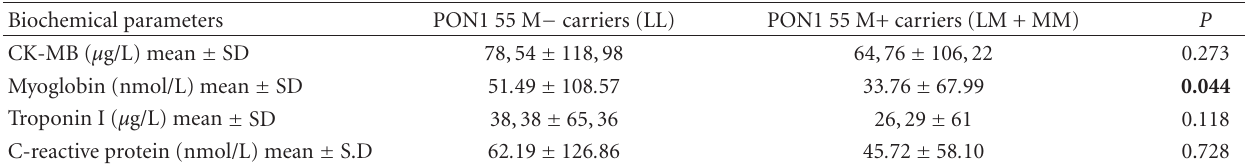
Table 3: Levels of biochemical parameters according to PON1 55 carriers in ACS